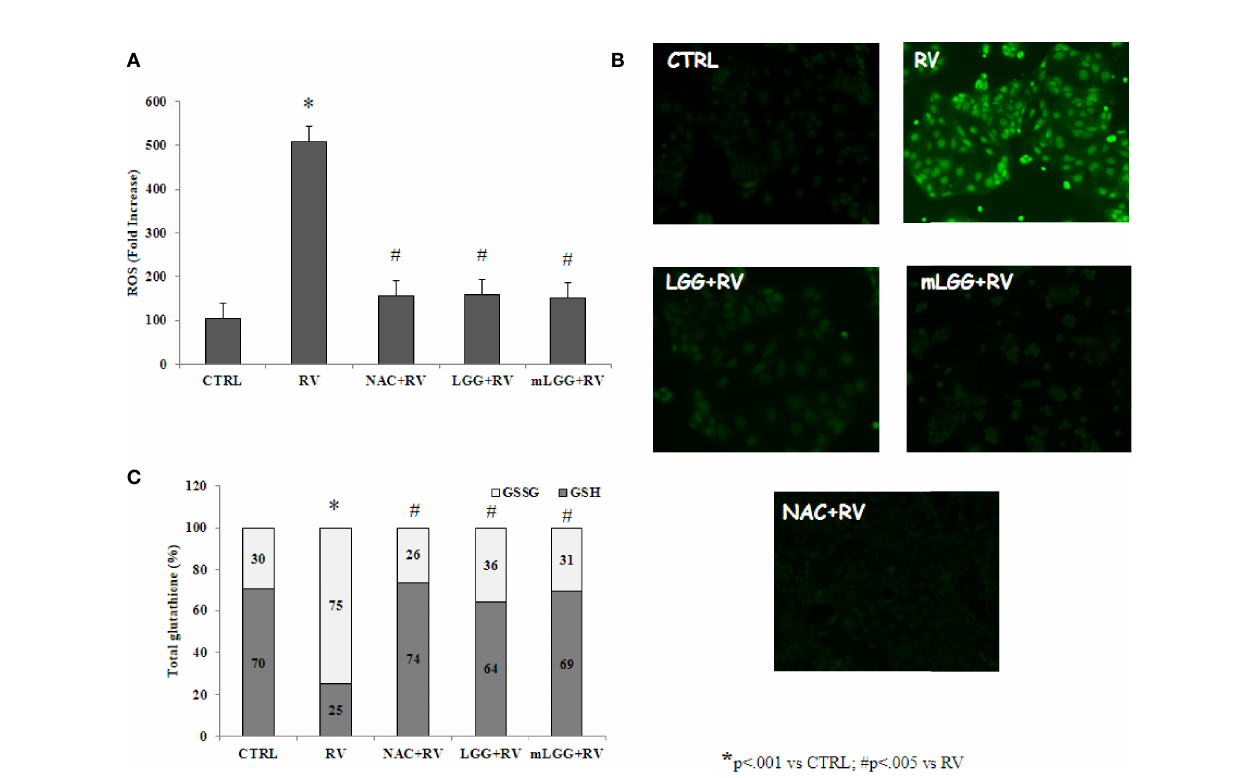
FIGURE 2 | Effect of LGG on oxidative stress induced by RV. (A) ROS production was evaluated in Caco-2 cell monolayers infected with RV preincubated with LGG or mLGG as described in the Methods. [*p< 0.05 vs CTRL; #p<0,05 vs RV]. (B) Caco2 cells were infected with RV following preincubation in the absence of LGG or mLGG and the fl uorescence of the ROS probe was evaluated one hour following infection. Magni fi cation: 400X (C) Caco-2 cells monolayers were infected with RV and glutathione was evaluated one hour following infection and levels of GSH (gray) and GSSG (white) were measured. LGG and mLGG preincubation are present during the activation phase of the virus as described in the Methods. [*p < 0.05 vs control; # p < 0.05 vs RV]. In all experiments, NAC was used as antioxidant